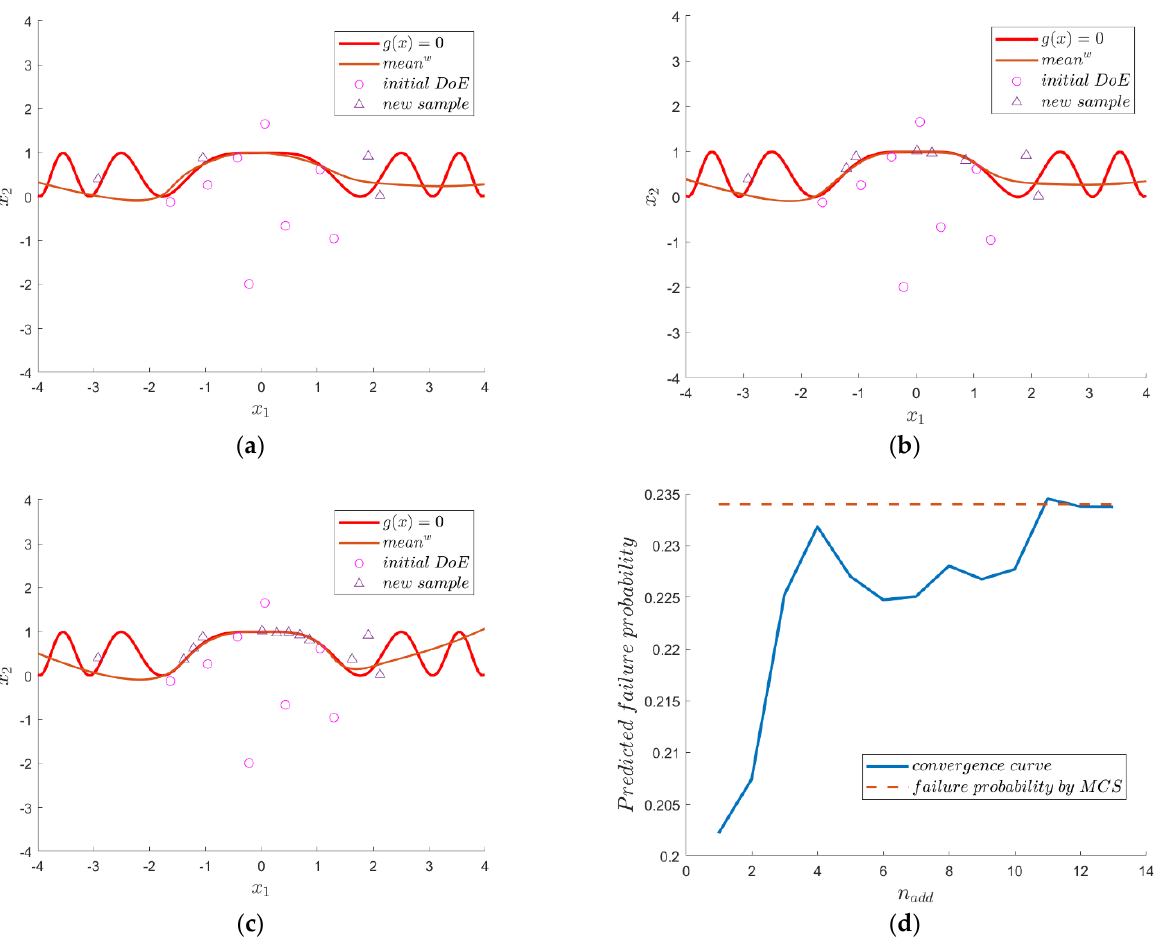
Figure 4. Step 5 − 9 of the demonstrated problem. ( a ) n add = 4. ( b ) n add = 8. ( c ) n add = 12. ( d ) Convergence curve.